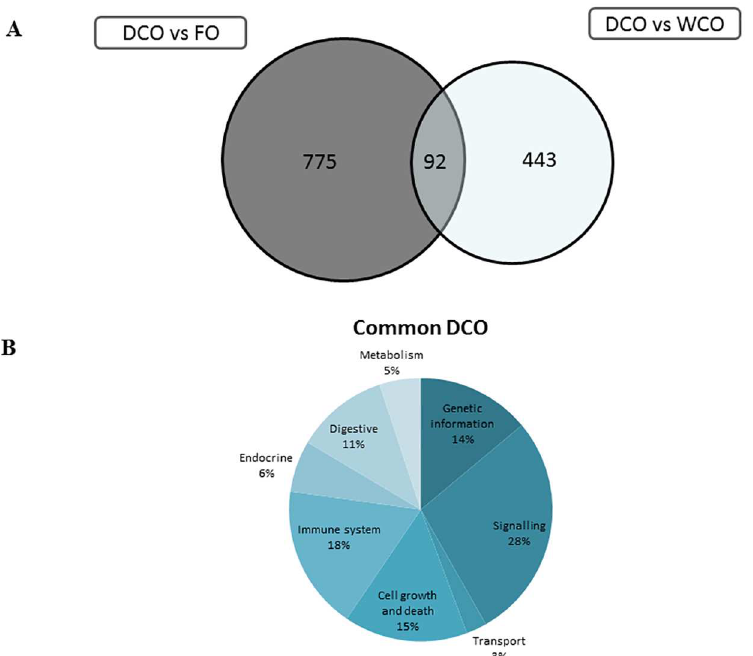
Fig 6. Impact of diet on hindgut transcriptome of Atlantic salmon fed diets containing Fish Oil (FO) or Wild type Camelina Oil (WCO) in comparison with fish fed fish EPA+DHACamelina Oil (DCO). (A) Venn diagramrepresentingtranscripts differentiallyexpressedin hindgutof Atlantic salmon fed diets FO and WCO comparedto diet DCO. The area of the circles is scaled to the number of transcripts (Welch t-test; p < 0.05; FC > 1.3). (B) Distributionby categoriesof common differentiallygenes in hindgutbetweenAtlantic salmon fed FO and WCO comparedto DCO-fed fish (Welch t-test; p < 0.05; FC > 1.3). Non-annotated genes and features corresponding to the same gene are not